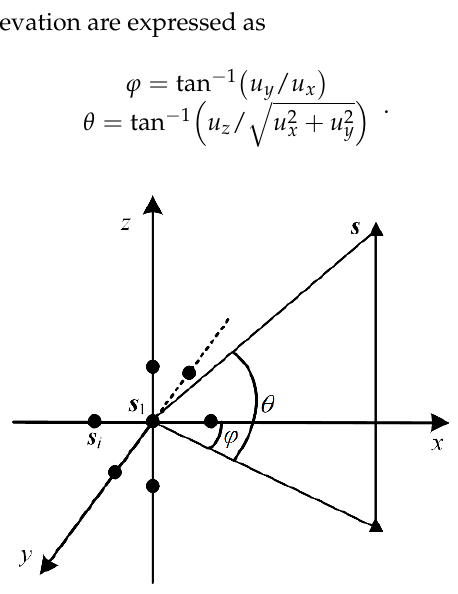
Figure 1. Positions of partial discharge (PD) source and antennas.